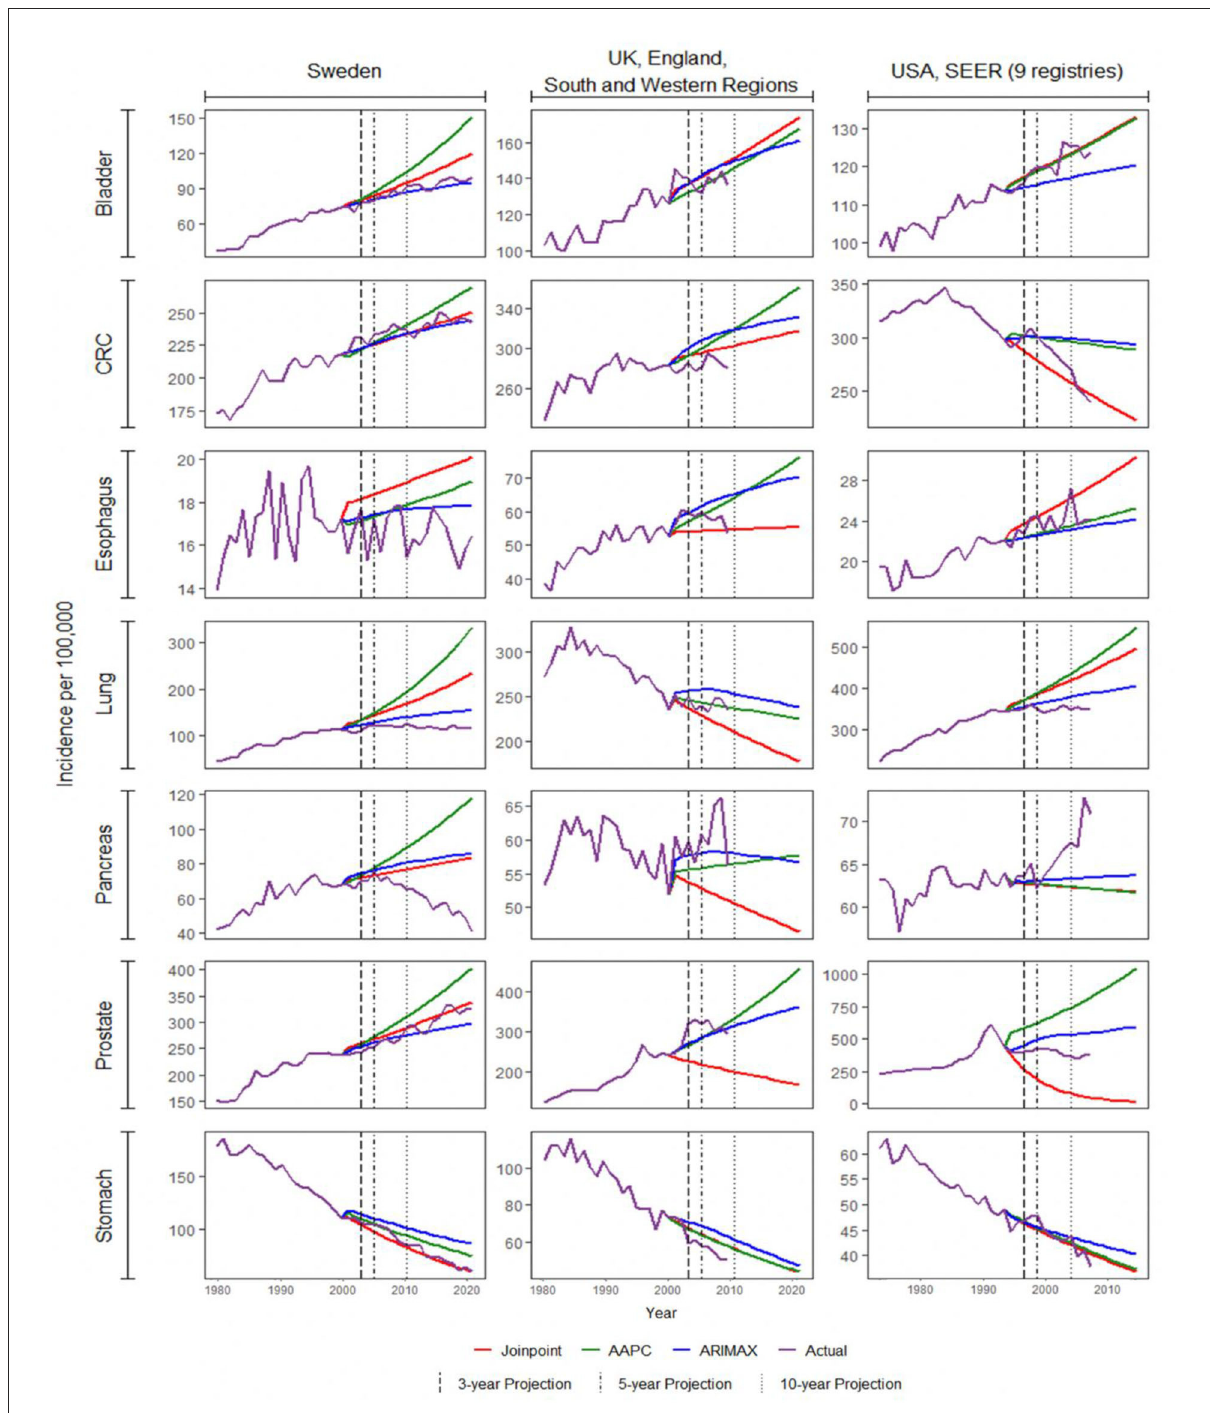
FIGURE2 Projection of cancer incidence for Sweden, UK, and US. AAPC, average annual percentage change; ARIMAX, autoregressive integrated moving average with exogenous variables; CRC, colorectal cancer.